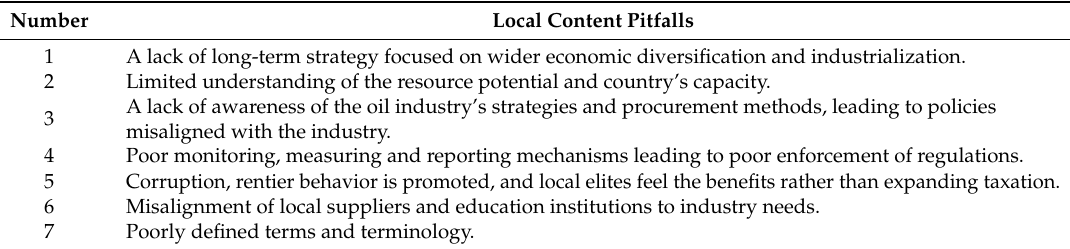
Table 4. Seven pitfalls to local content policies